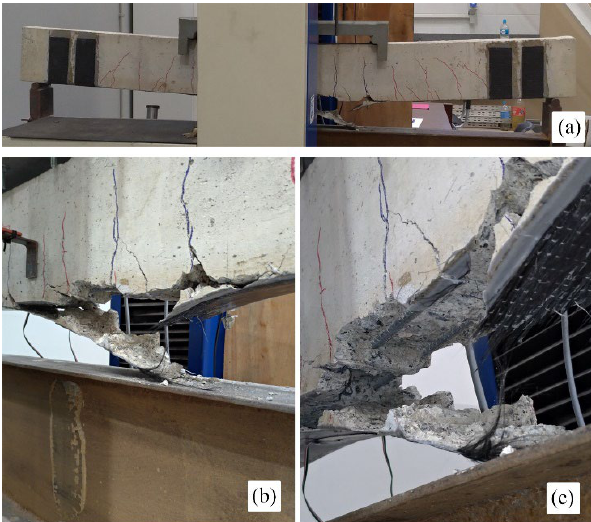
Figure 18. Failure of beam CR63-NI (a); Detail of the rupture and debonding of the CFRP sheet (b); Detail of the non-rupture of the positive reinforcement